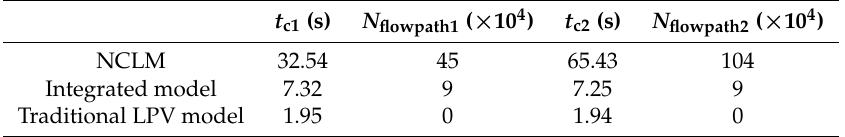
Table 2. Comparison of time consumption and iterative